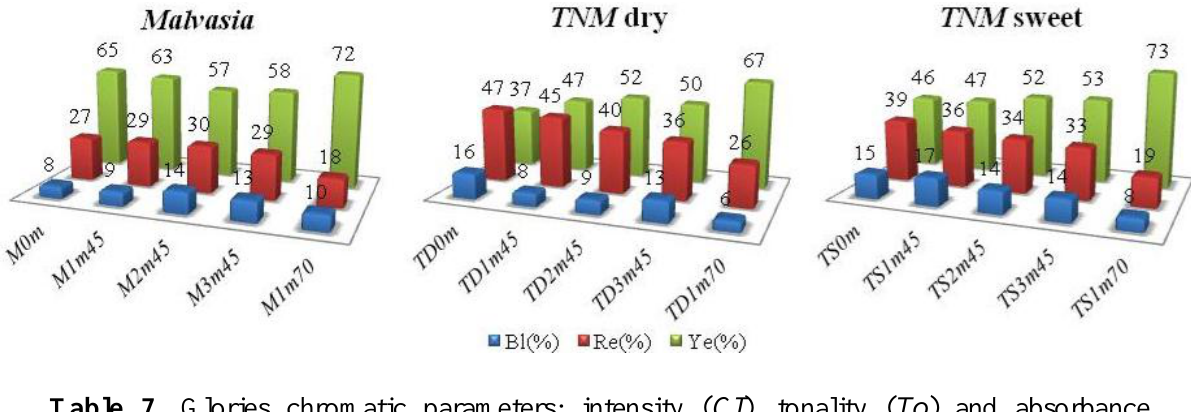
Table 7. Glories chromatic parameters: intensity ( CI ), tonality ( To ) and absorbance readings at 420 nm of Madeira wines submitted to heating at 45 °C (3 months) and 70 °C (1